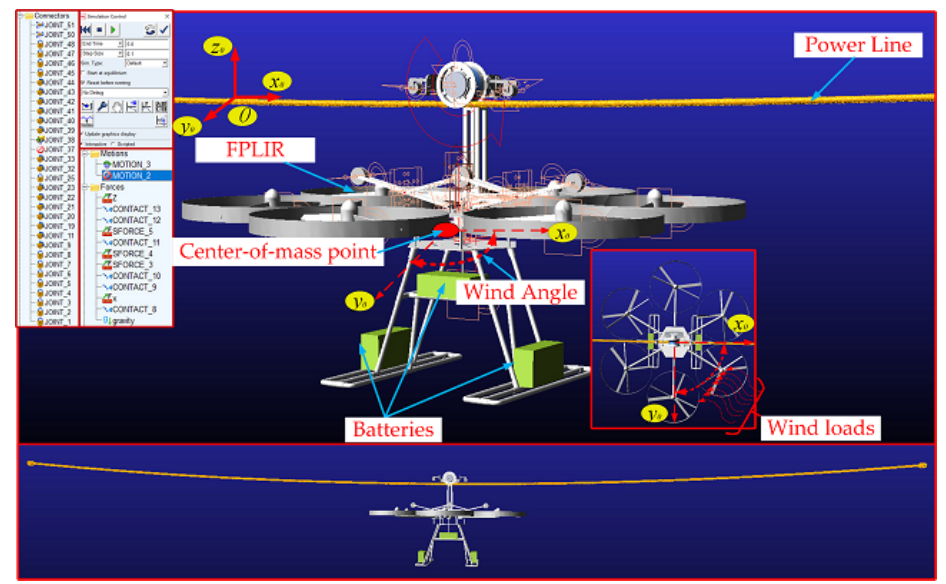
Figure 14. Simulation diagram of the FPLIR in the ADAMS software.